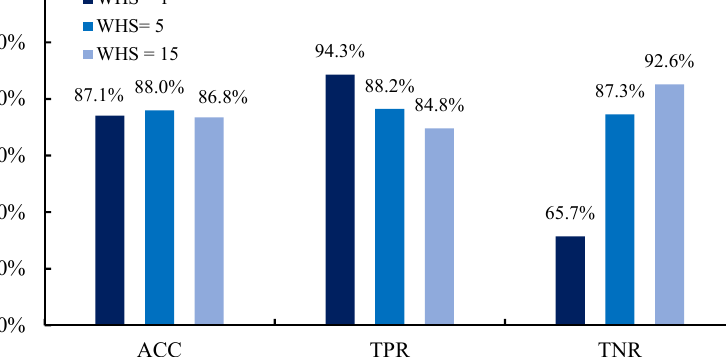
Figure 16. Category weight of safe sample is set to 1, and category weights of hazardous sample are 0.5, 5, and 15, respectively. The ACC, TPR, and TNR of AIEFPC on the test set aD8-4 and bD8-4 samples. WHS is the category weight values of the hazardous sample.